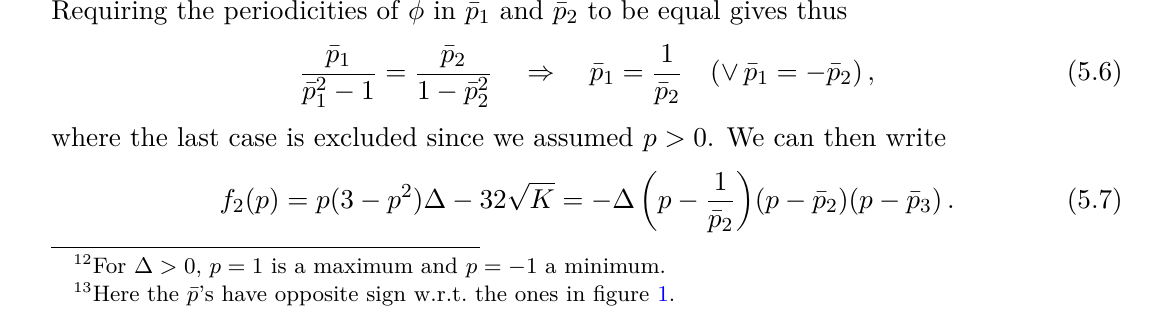
Figure 1 . Graph of f 2 for: (a) 0 > ∆ > − 16 the sign of ∆ produces a reflection of f